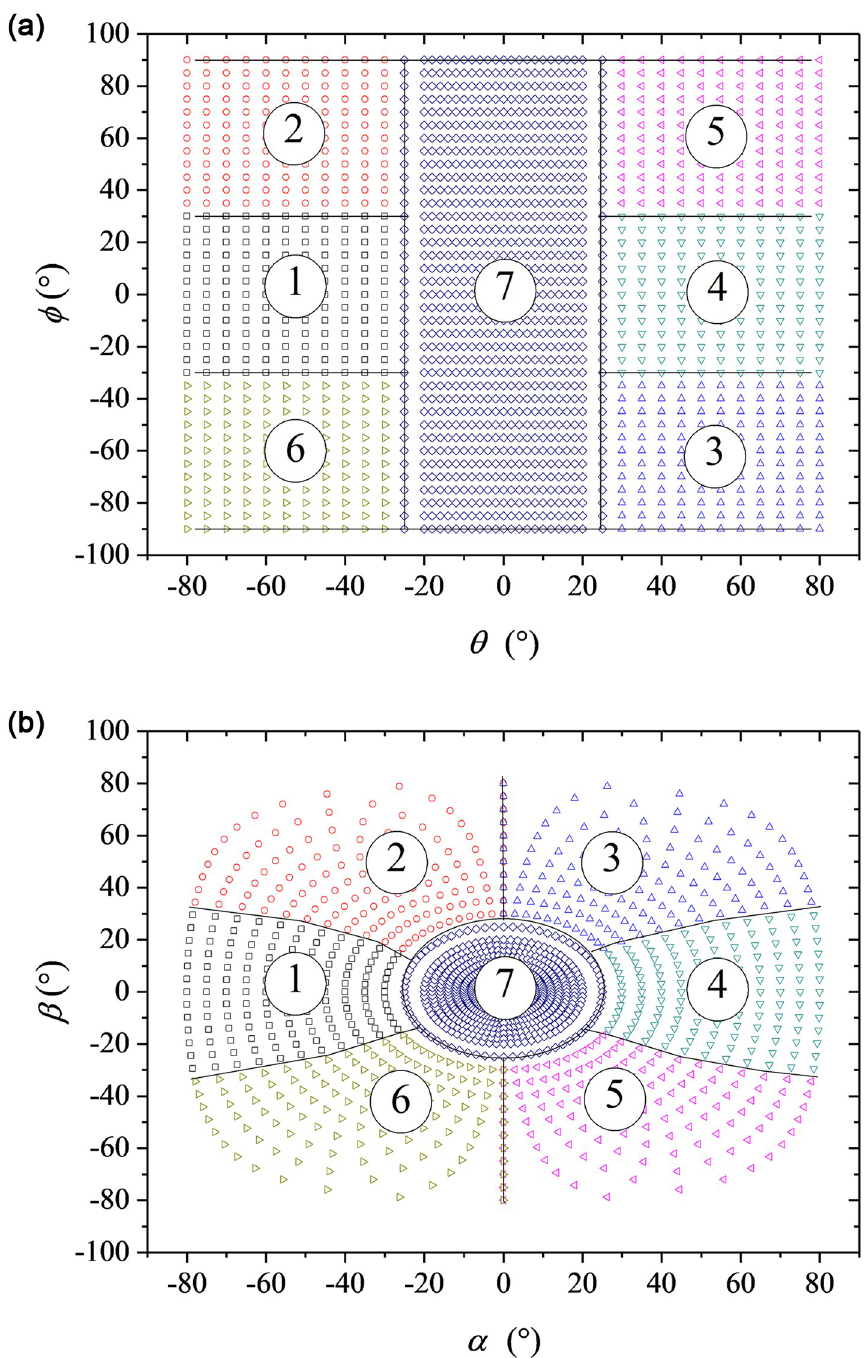
Fig 3. Angular range of calibration database, θ ~ ϕ coordinates (a), α ~ β coordinates